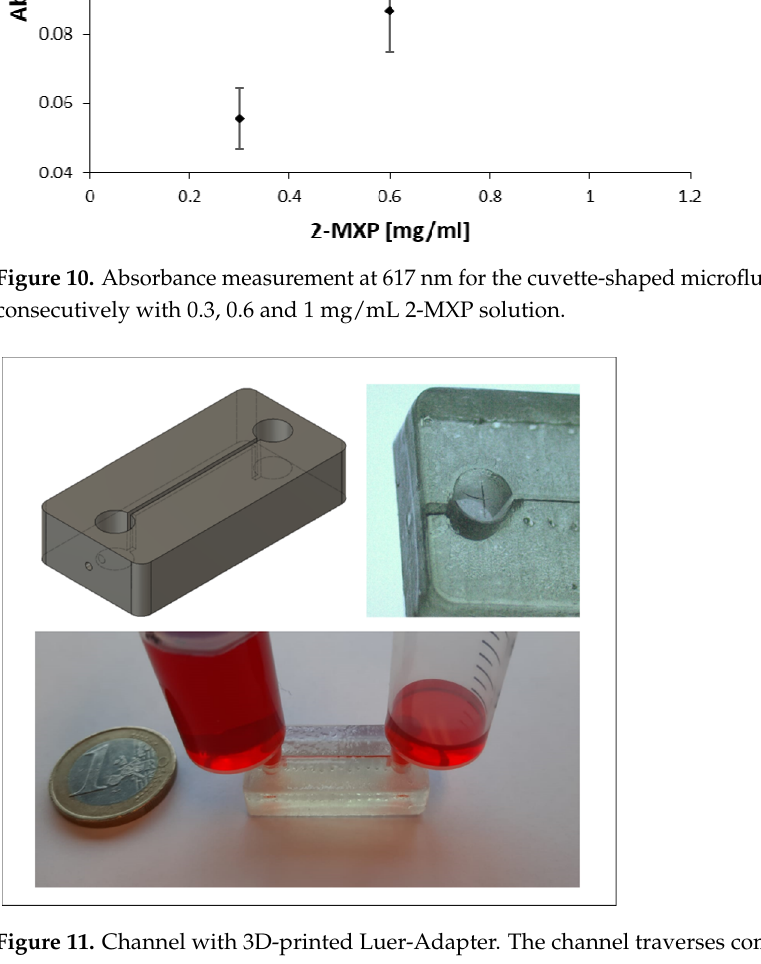
Figure 11. Channel with 3D-printed Luer-Adapter. The channel traverses completely on the upper surface and thus can be easily injection